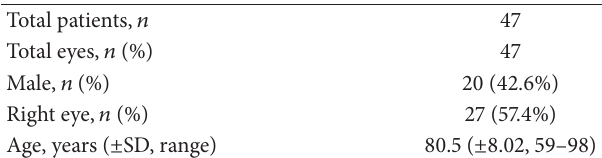
Table 1: Baseline characteristics.